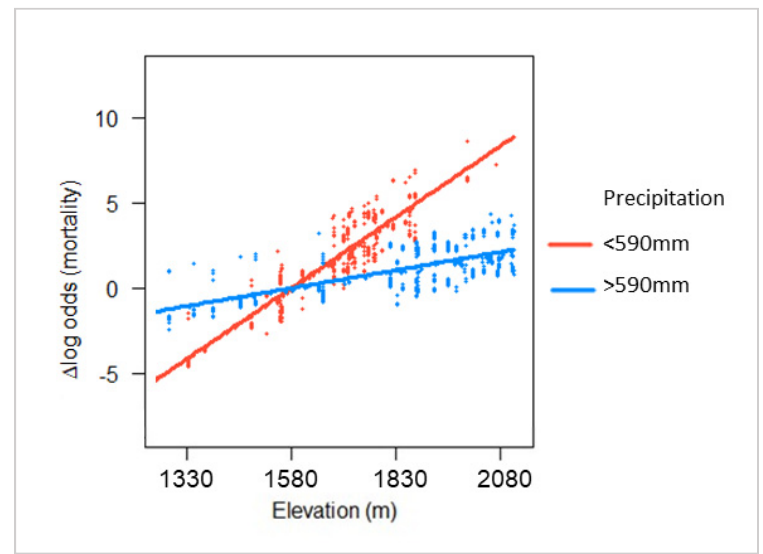
Figure 4. Proportion mortality at high and low elevation, split by precipitation. Higher elevations were associated with higher mortality ( p < 0.001), but this effect was reduced in stands receiving a higher average annual precipitation.